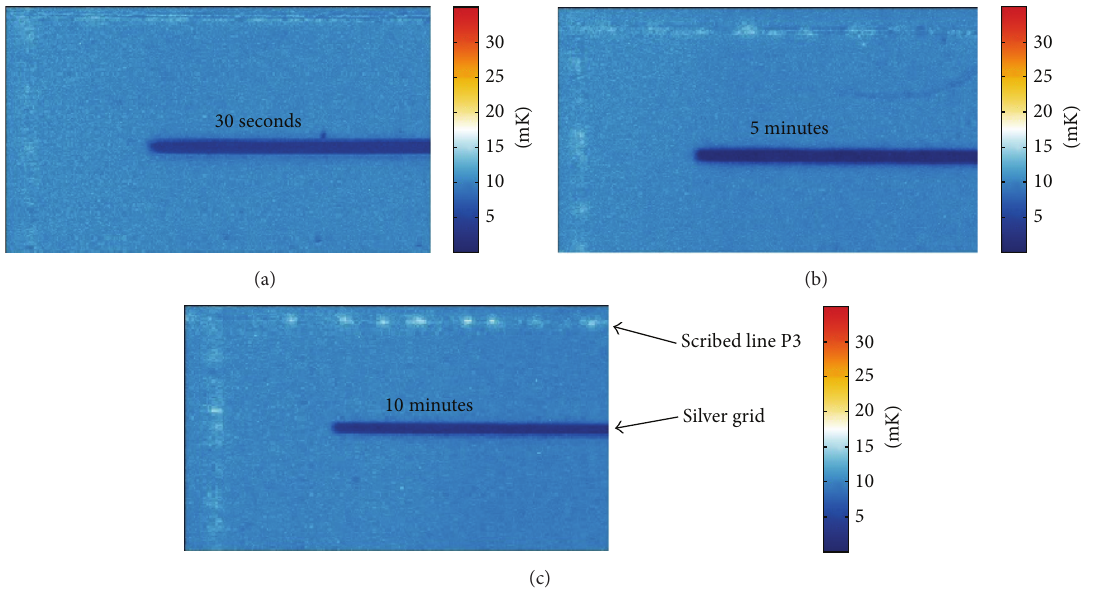
Figure 8: LIT images of sample heated for 30 seconds (a), 300 seconds (b), and 600 seconds (c) after being exposed to 300 ∘ C.